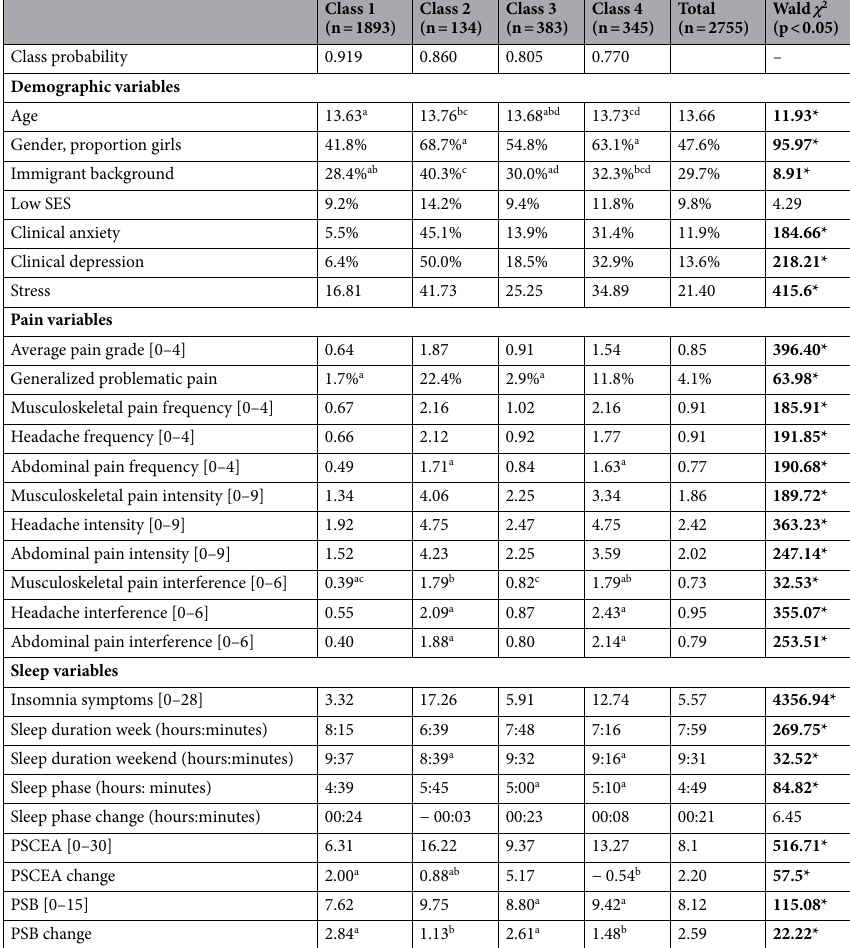
Table 3. Sociodemographic data (mean or percentage) and differences of classes at baseline (T1). The variables with the post-script “change” refer to the change score of the variables value at T4 minus the value at T1. These were included to highlight how these variables changed from T1 to T4. Pairwise comparisons, based on Wald χ 2 tests, were done between all classes on all variables. Since most comparisons were significant, the superscripts represent specifically the class comparisons that did not significantly differ; all class comparisons without superscript differed at p < 0.05 level. The values with the same superscript (a, b, c or d) did not differ significantly from each other. For instance, regarding gender, only class 2 and 4 did not significantly differ from each other. Note that pairwise comparisons were not done on variables with non-significant overall tests. PSCEA pre-sleep cognitive-emotional arousal, PSB pre-sleep behavior. Significant values are in bold. * p < 0.05.